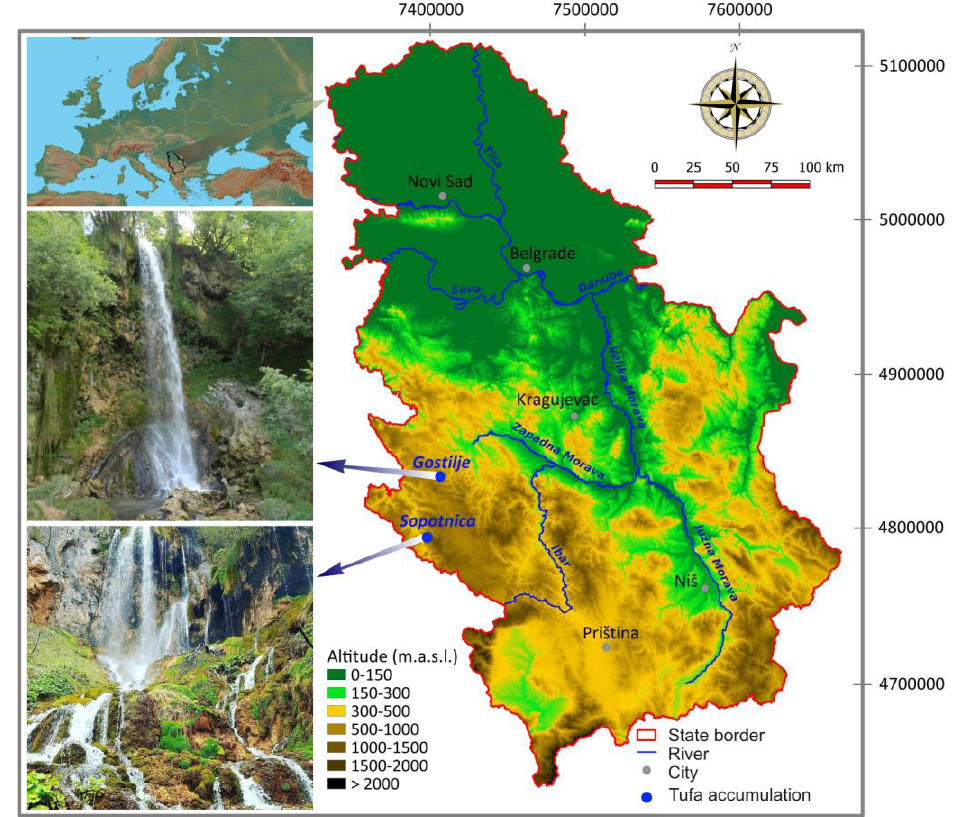
Figure 1. Geographical position of the studied sites.